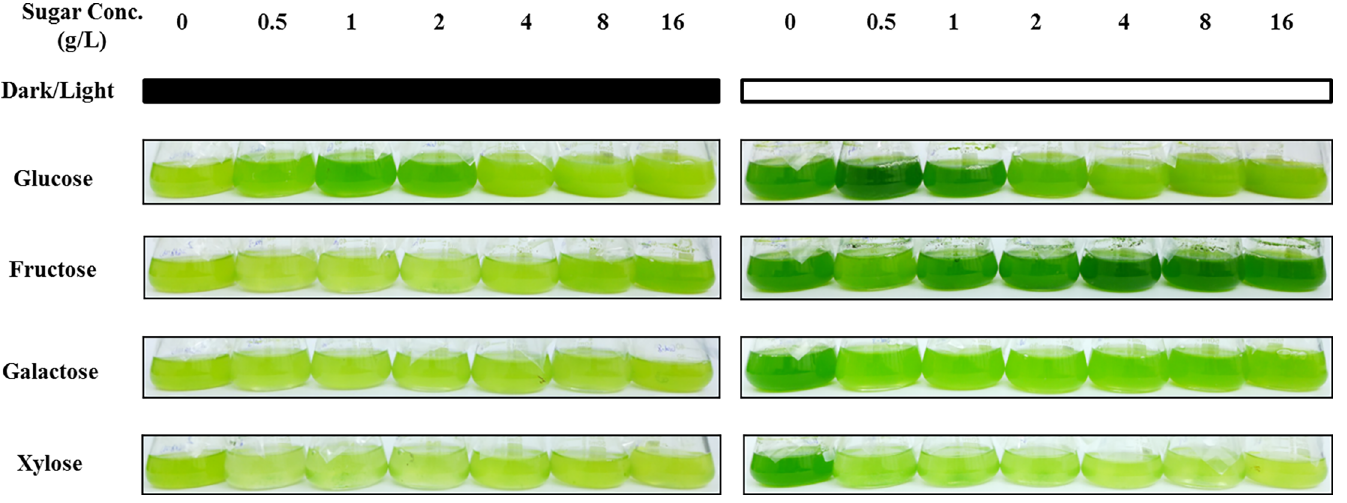
Fig 1. Morphological appearance of Chlorella sorokiniana UTEX 1230 grown in monosaccharide-supplemented medium. Photos of C . sorokiniana UTEX 1230 cultivated for 7 days in medium supplemented with different concentrations of monosaccharides. Left (black bar) and right (white bar) panels show flasks cultured under dark and light conditions, respectively. The photos were taken with a digital camera against a white background.